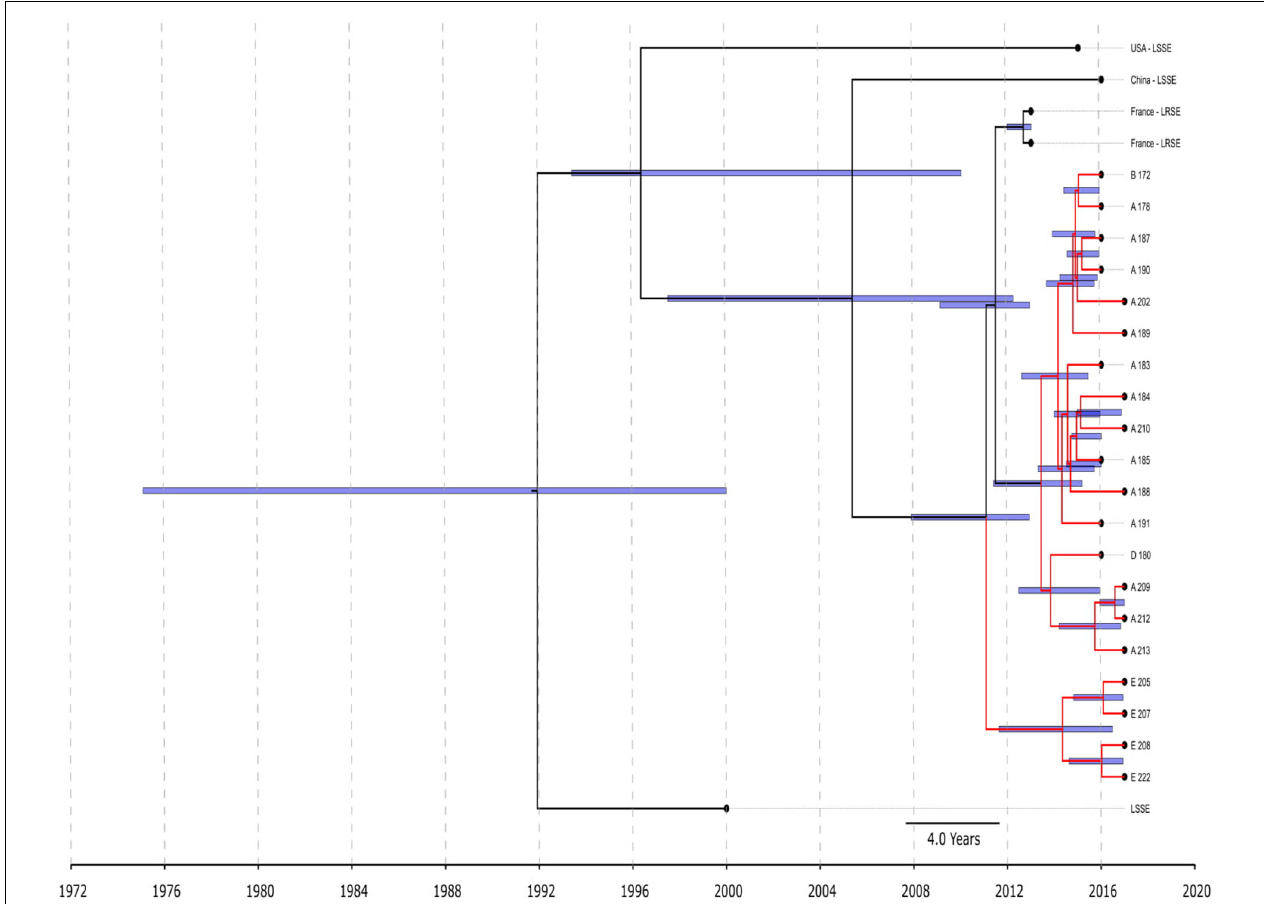
FIGURE 3 | Chronogram of S. epidermidis ST22 ( n = 25) based on core-SNP alignment and BEAST. Three linezolid-susceptible S. epidermidis from different countries were included in the analysis. LRSE ST22 from Russia (red branches) and France were included in the analysis. Title of Russian isolates is matched of site isolation. 95% CI of time appearance (blue bars) shown near the